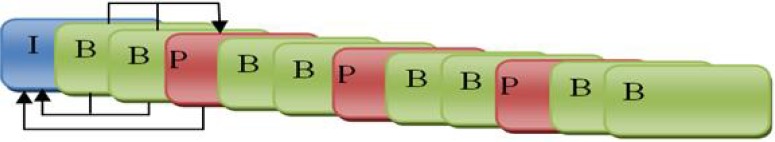
A twelve-frame classic GoP [17].